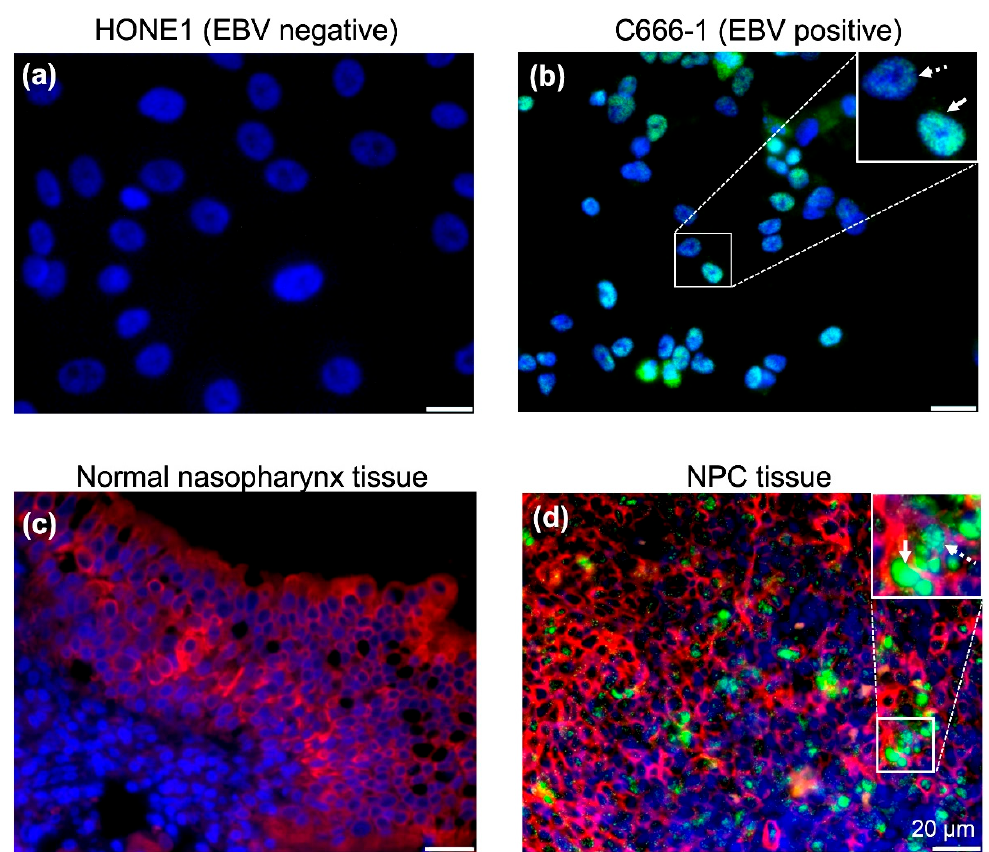
Figure 2. Detection of EBER1 signals by RNAscope in situ hybridization system. EBER in situ hybridization (ISH) was performed on EBV-positive and EBV-negative cells using the EBER1 probe (#310271) by RNAscope detection system. ( a ) HONE1 cell, ( b ) C666-1 cell, ( c ) normal pharynx tissue, and ( d ) NPC tumor tissue were examined to detect EBER1, respectively. Solid arrow that shows diffuse staining pattern as well as dotted arrow that indicates discrete speckled staining pattern are indicated in the inserts. Nuclei are stained blue by DAPI. EBER1 ISH signals are shown in green. Cytokeratin immunostaining signals are shown in red.